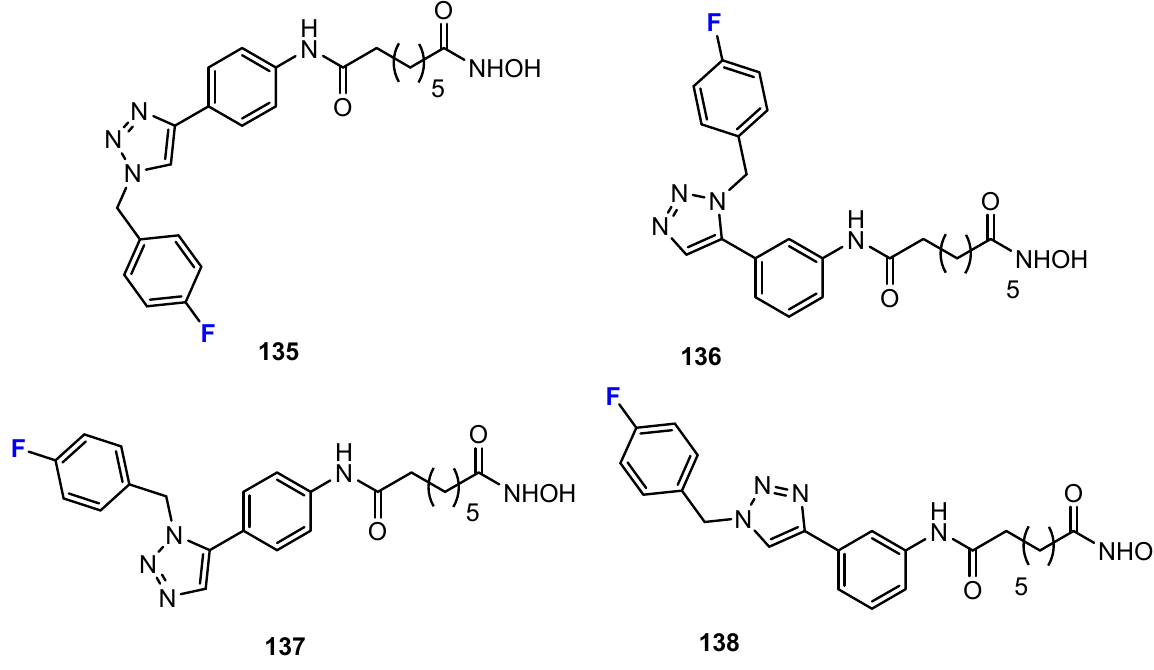
Figure 9. Chemical structures of fluorinated hydroxamic acids by Chen et al. [80,81].